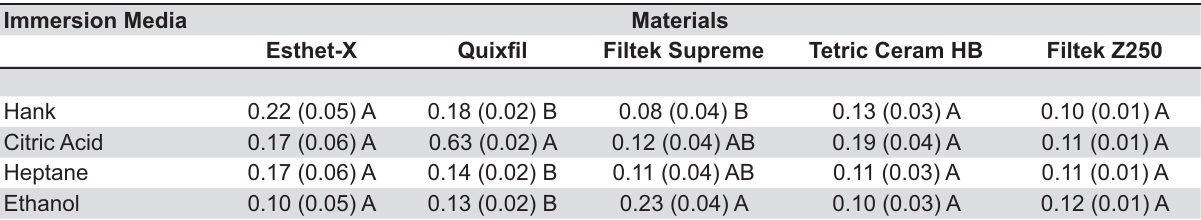
Table 1- Surface roughness means (Ra, μm) and standard deviations after immersion in the food-simulating solutions and brush simulation